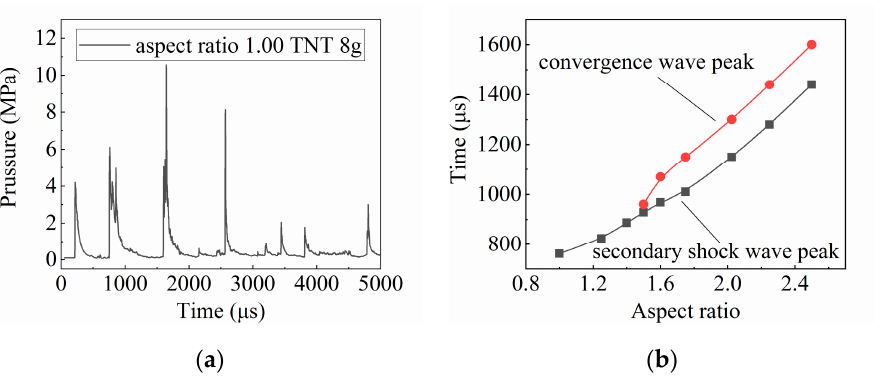
Figure 9. ( a ) The pressure curve at the pole under the 1.00 vessel aspect ratio; ( b ) Time interval between the convergence wave peak (red dot solid line) and the secondary shock wave peak (black dot solid line) under the 1.00 vessel aspect ratio.